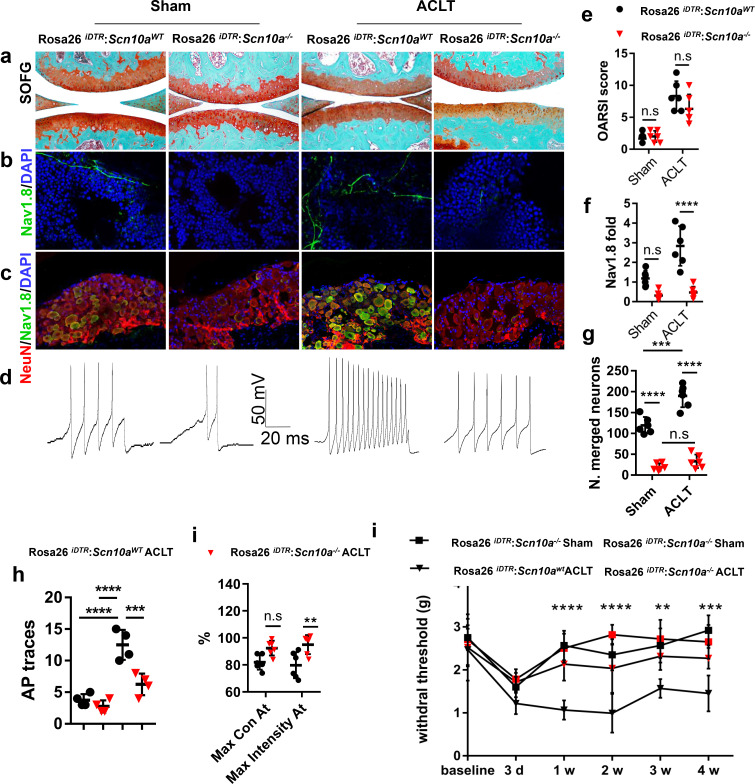
Mechanical allodynia is reduced in Scn10a-Cre::Rosa26iDTRfl/fl ACLT mice.(a–d) Representative photos of knee joint Safranin Orange and fast green staining (a), Nav1.8 (green) and DAPI (blue) immunofluorescence in subchondral bone (b) and NeuN (red, Nav1.8 (green) and DAPI (blue) co-immunostaining of ipsilateral L4 DRGs (c) and APs (d) after sham or ACLT surgery at 1 m. Scale bars, 500 μm (a), 20 μm (b) and 100 μm (c), n = 6 per group. (e–j) Statistical analysis of OARSI score (e), Nav1.8 immunofluorescence signal in subchondral bone (f), number of NeuN, Nav1.8 co-immunostained neurons in ipsilateral L4 DRG (g), number of AP (h), catwalk gait analysis (i) and left hindpaw PWT (j) after sham or ACLT surgery. n = 6 per group, *p<0.05, **p<0.01, ***p<0.001, ****p<0.0001 compared with the sham-operated group at different time points. Statistical significance was determined by multifactorial ANOVA WITH BONFERRONI POST HOC TEST (e–h and j) or unpaired Student’s t test (i), and all data are shown as scattered plots with means ± standard deviations.Figure 5—source data 1.Raw data of OARSI, subchondral Nav1.8 fiber density, NeuN nav1.8 costaining, Von Frey tests, catwalk analysis, GcAMP3 imaging, and electrophysiological recordings.